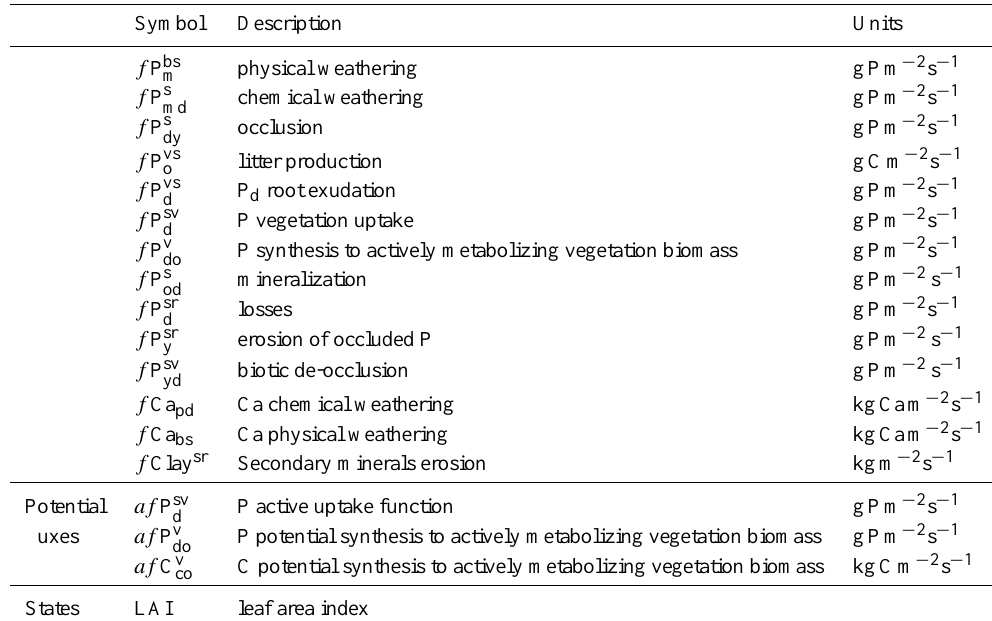
Table A3. Description of model variables relevant for the P cycle (part 3 of 3).